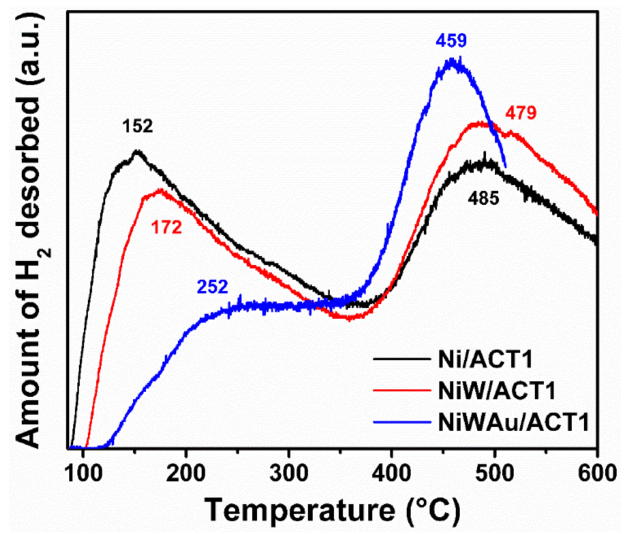
Figure 12. TPD-H 2 profiles of reduced trimetallic nanomaterials at 400 ◦